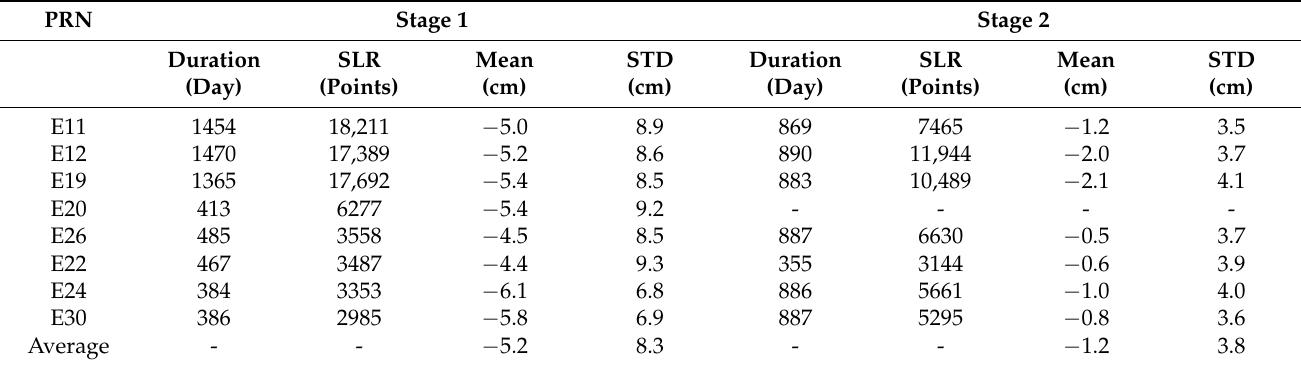
Table 10. Statistical information for SLR residuals calculated from TUM